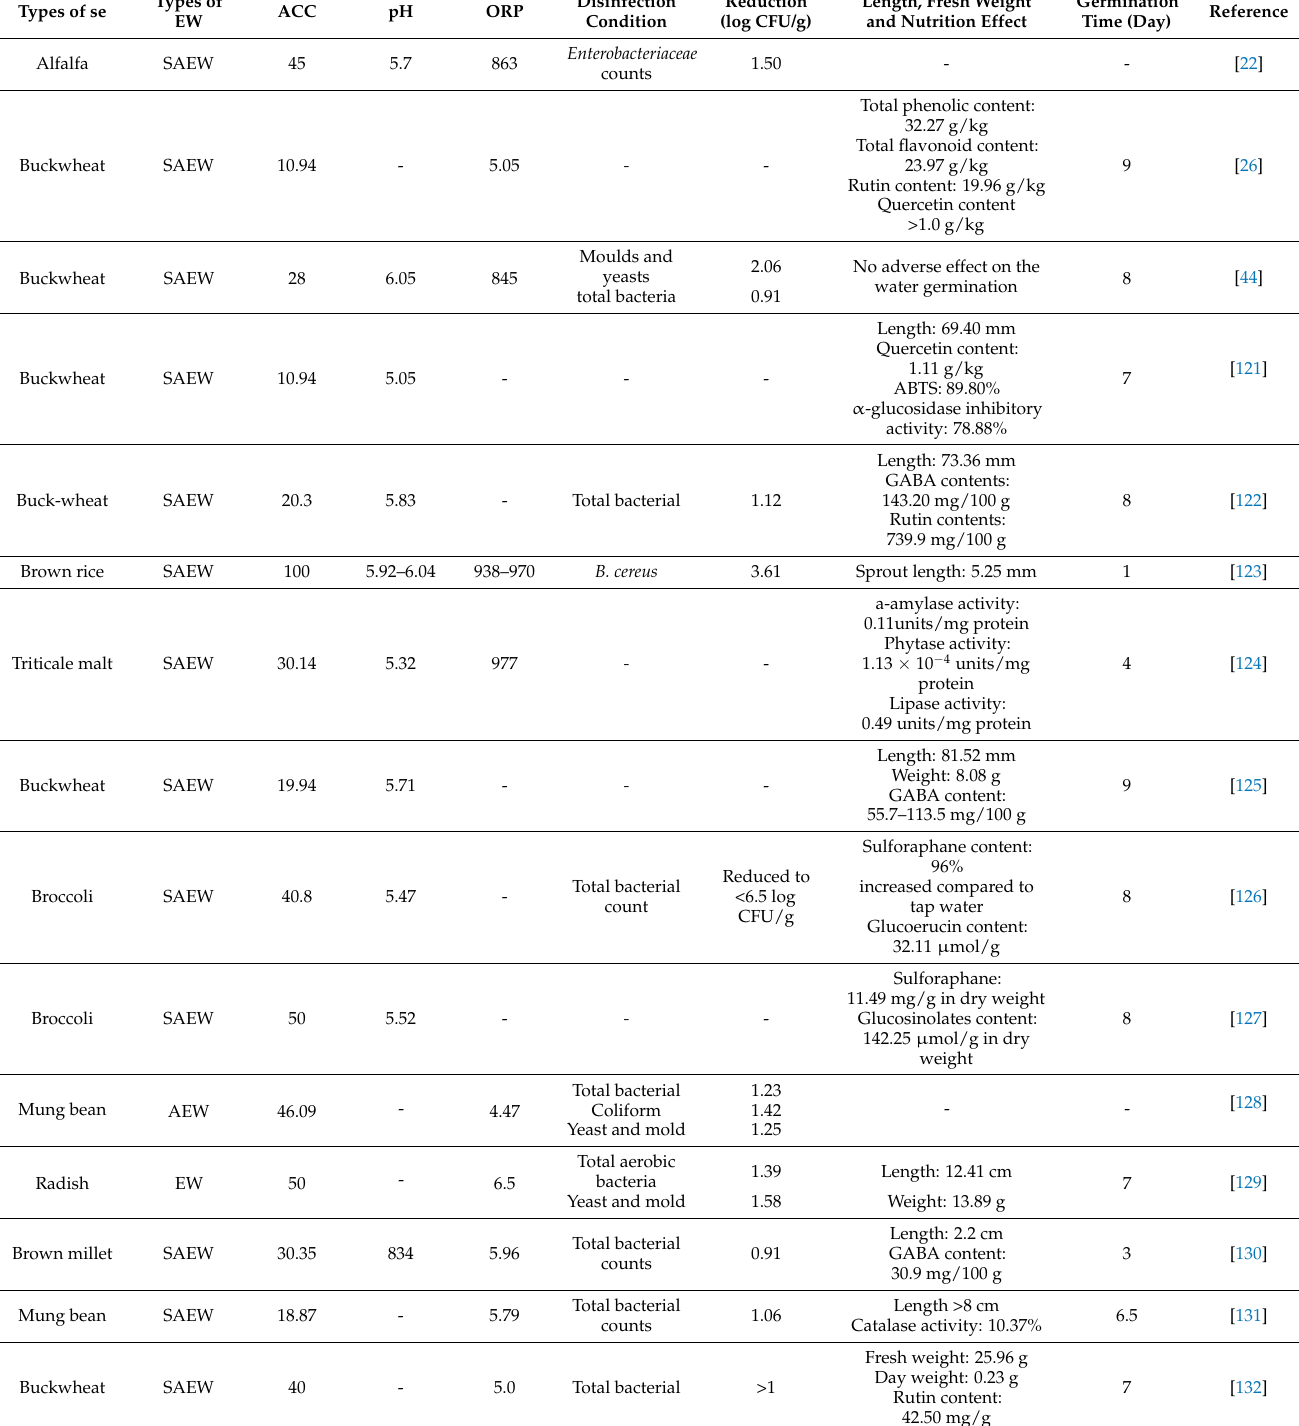
Table 6. Application of EW in germinated